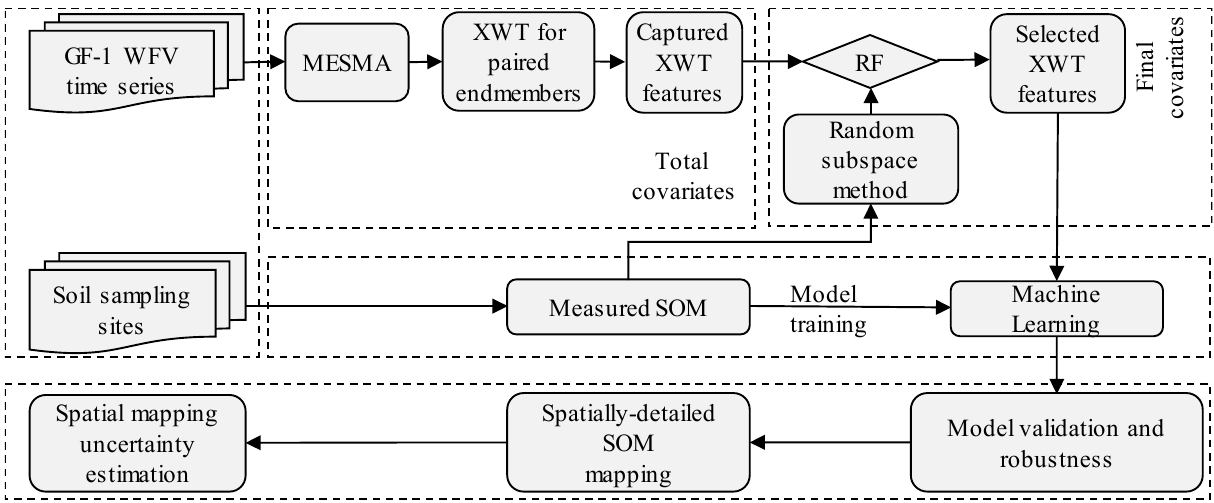
Figure 2. Overall workflow of the XWT-based framework for SOM mapping. MESMA represents multiple endmember spectral mixture analysis for unmixing four endmember fractions from GF-1 WFV imageries, corresponding to green vegetation, dark surface, saline land, and sand land. RF, representing random forest, is one of the state-of-the-art machine learning approaches for feature selection and soil mapping.